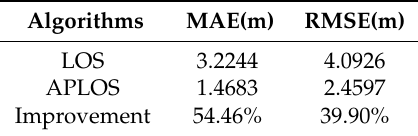
Figure 17. Lawnmower path following ( u = 1 m/s). ( a ) comparison of trajectory; ( b ) comparison of cross-track error; ( c ) comparison of look-ahead distance; ( d ) comparison of velocity and drift angle; ( e ) comparison of heading effect. Table 7. Performance metric of lawnmower path following ( u = 1